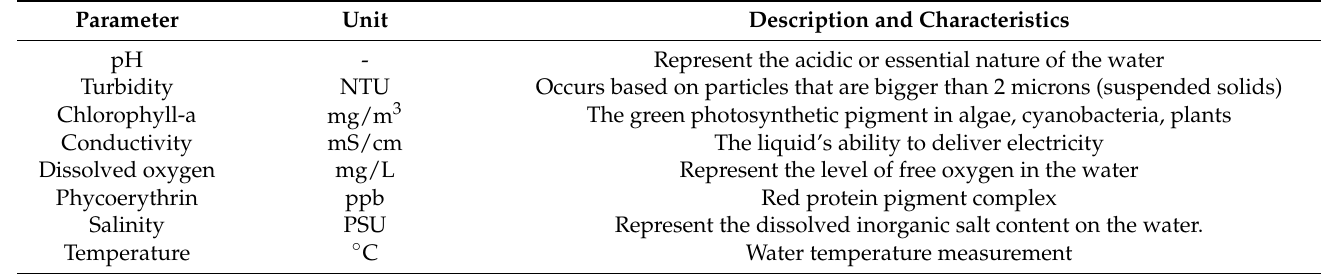
Table 2. Defined coastal water quality